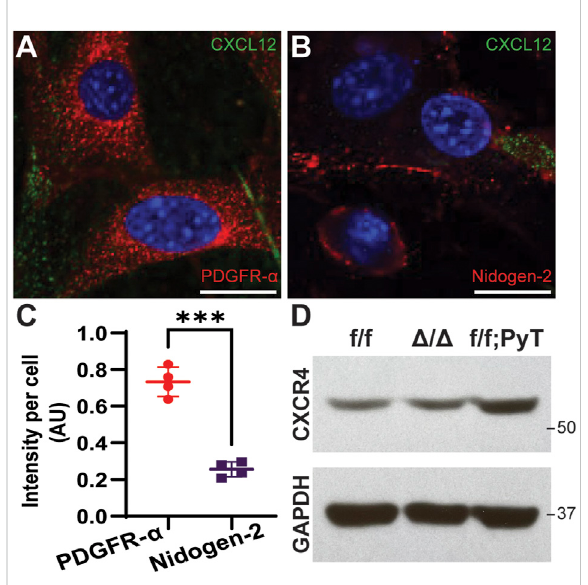
FIGURE 1 Molecular characterization of fi broblasts isolated from mouse mammary glands. (A , B) Representative confocal images of cancer-associated fi broblasts (CAFs) by immuno fl uorescence (IF) staining of CXCL12 (green) and PDGFR- α (red for A ) and Nidogen-2 (red for B ). Nuclei (blue) were counterstained with DAPI. Scale bars are 20 µm. (C) Quanti fi cation of fl uorescence intensity of PDGFR- α and Nidogen-2 per cell from confocal IF images. Values represent the mean ± standard deviation, with n = 4 technical replicates: * p ≤ 0.05, ** p ≤ 0.01, *** p < 0.001